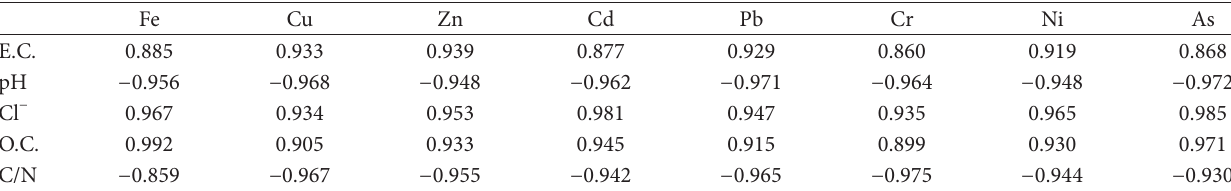
T 6: Correlation coe�cient of physico-chemical parameters of soil with heavy metals in soil as in�uenced by jute mill solid